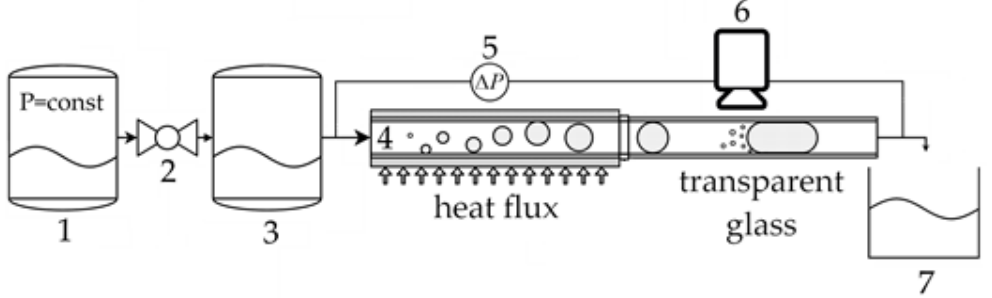
Figure 1. Schematic diagram of the experimental setup: ( 1 ) supply tank; ( 2 ) ball valve; ( 3 ) surge tank; ( 4 ) heated minichannel; ( 5 ) pressure drop sensor; ( 6 ) high-speed camera; ( 7 ) overflow tank. The Phantom v1610 high-speed camera (6—Figure 1) was used to record the flow patterns inside the minichannel at a frame rate equal to 1000 fps. During the experiment, high-amplitude density wave oscillations ( DWO ) superimposed on the long-period pressure drop oscillations ( PDO ) were observed over a short period. Pressure drop and videos were recorded for a whole PDO cycle occurring for constant mass flow rate G and input heat flux P . The pressure drop oscillations during a single PDO cycle shown in Figure 2 (acquired at 1000 Hz) were used for analysis. In a single PDO cycle, the following flow patterns were observed: liquid flow, bubble flow, confident bubble flow, slug flow, elongated slug flow, churn flow, and wavy annular flow.